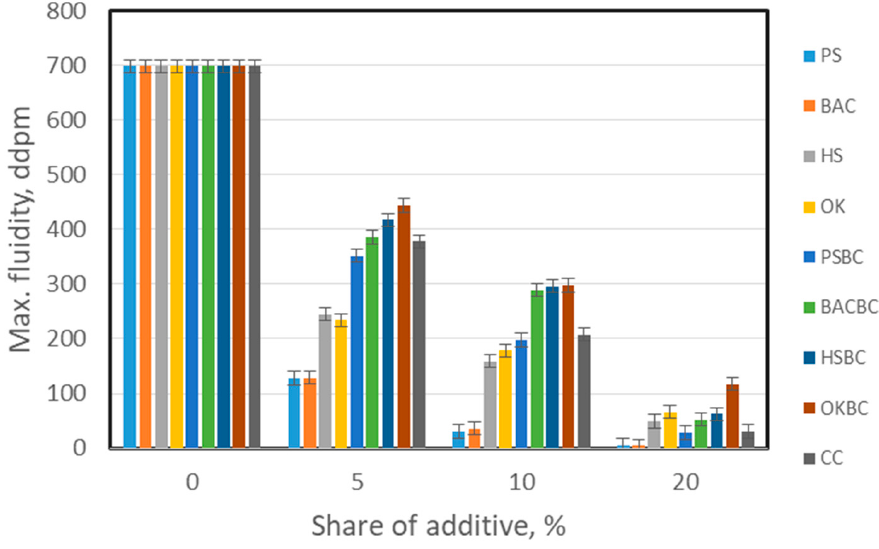
Figure 4. Influence of type and share of bio-components on maximum fluidity.